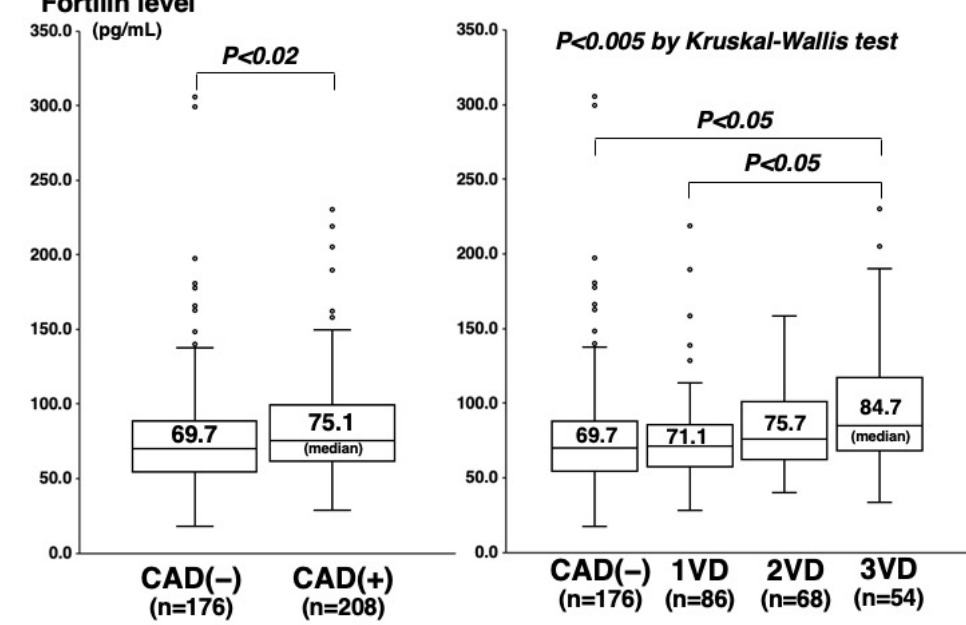
Figure 1. Fortilin levels and CAD or the number of stenotic vessels. Fortilin levels were higher in the CAD(+) group than in the CAD( − ) group ( p < 0.02) ( left ), and they were the highest in the 3VD group ( p < 0.005) ( right ). The central line and box show the median and 25th to 75th percentiles.